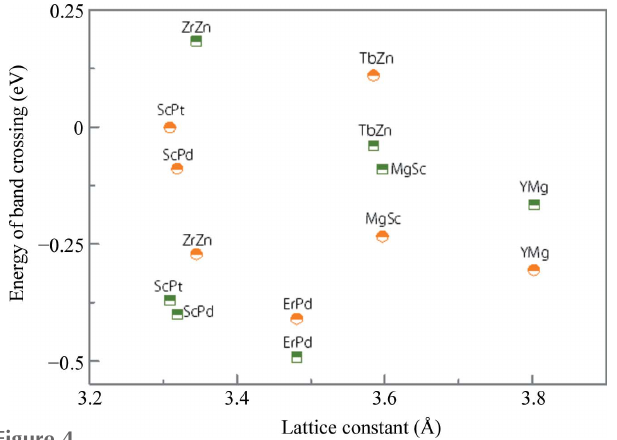
Figure 5 ( a ) Electronic band structure of YIr. The red dot denotes the triple nodal point. ( b ) Projected spectrum on the (001) surface of YIr. The red arrows point to the Fermi arc originating from the triple nodal